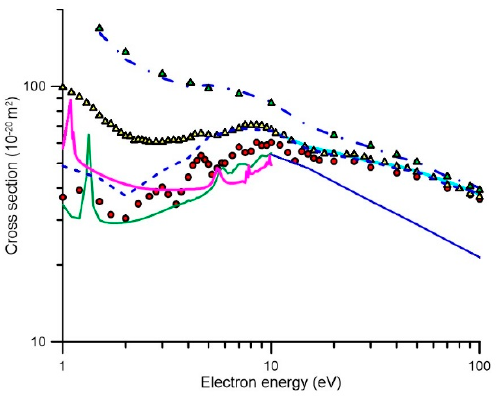
Figure 4. Total electron scattering and integral elastic cross sections for electron collisions with pyridine: , present experimental data [3]; , experimental data from [14]; , experimental data from [14] including the correction for rotational excitations into the acceptance angle of the detector (“missing angles”); ― integral elastic cross section calculated with the SMC method; ― , integral elastic cross section calculated with the R-matrix method; ― , integral elastic cross section calculated with the IAM-SCAR method; --- , our experimental data [3] including the correction for electrons elastically scattered into the “missing angles” as calculated with the IAM-SCAR differential elastic cross sections. -.-. ; our experimental data [3] including both the corrections for elastic and rotational excitation scattered electrons into the “missing angles”.